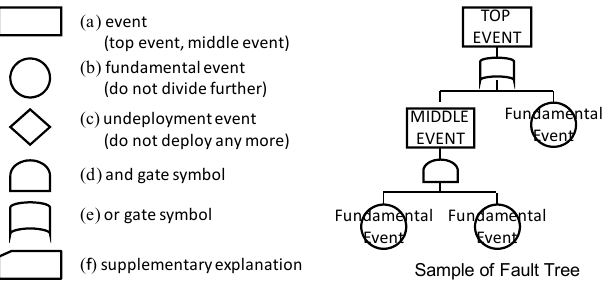
Figure 3. Fault tree (FT) symbols used in fault tree template (FTT).